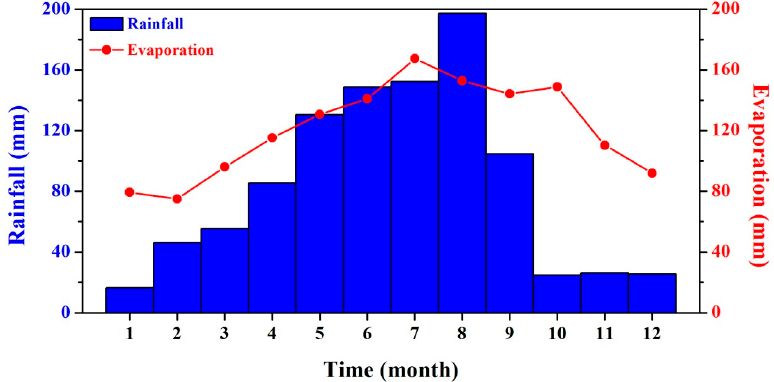
Figure 2. Monthly average of rainfall and evaporation in the Penghu Islands for the period 1981–2015.